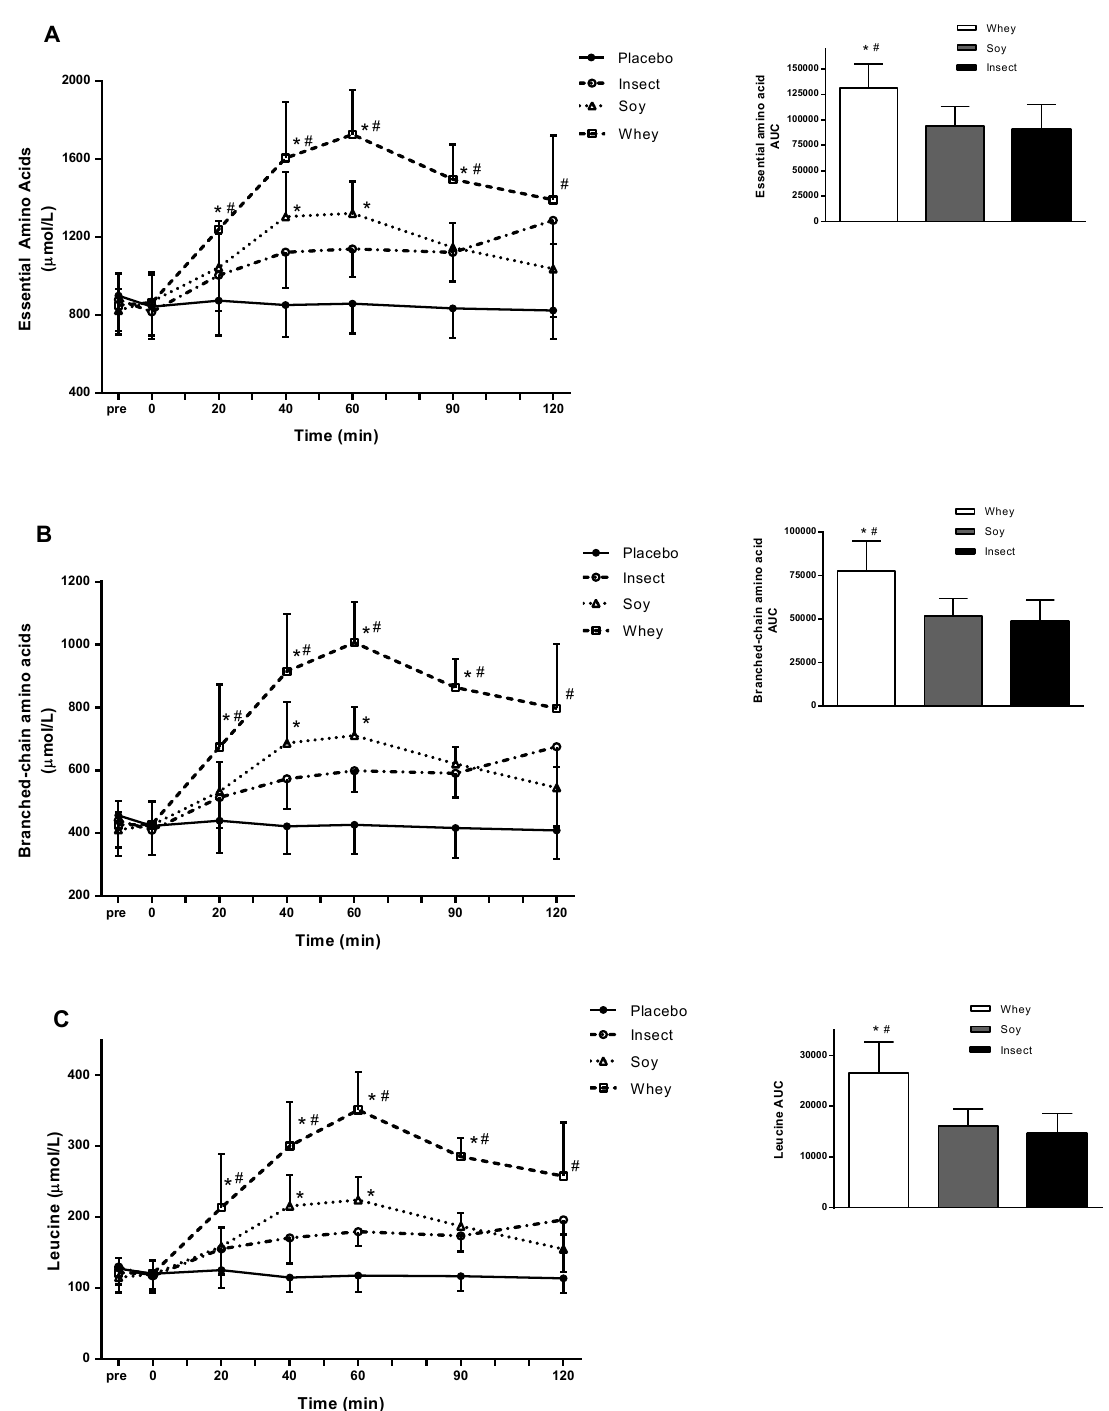
Figure 2. Blood concentrations of essential amino acids ( A ), branched-chain amino acids ( B ), and leucine ( C ) after ingestion of whey, soy, or insect protein isolate. Insert: area under the curve (AUC) analysis for each concentration evaluated as incremental AUC from time = 0 min. * Significant different from insect protein ( p < 0.05). # Significant different from soy protein ( p < 0.05). All data was significant different from placebo at all time-point after 0-min. All values are mean ± SD; n = 6 per group.